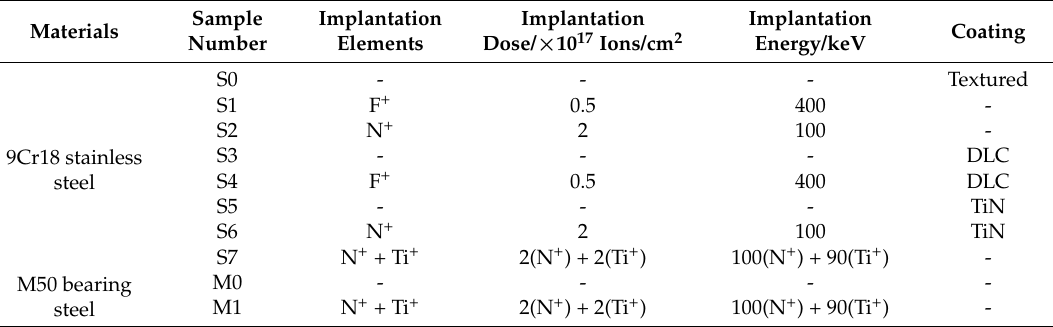
Table 1. Parameters of the as-treated